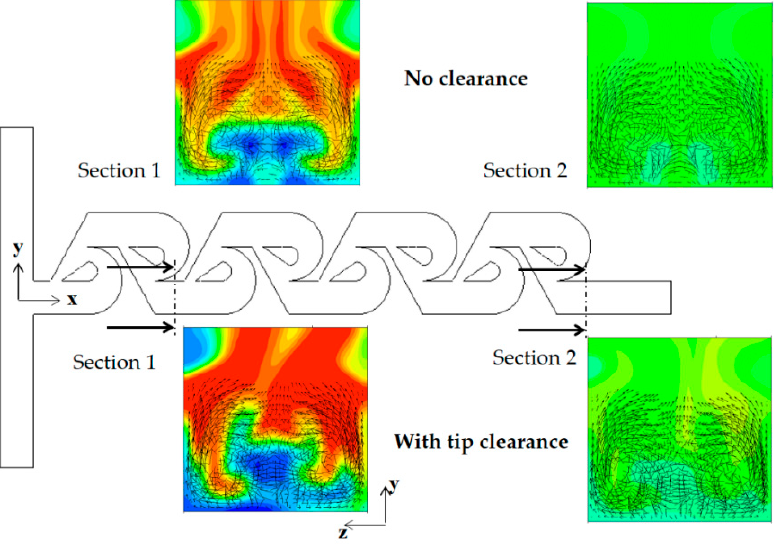
Figure 17. Concentration contours and velocity vector on the yz planes for Re = 50.